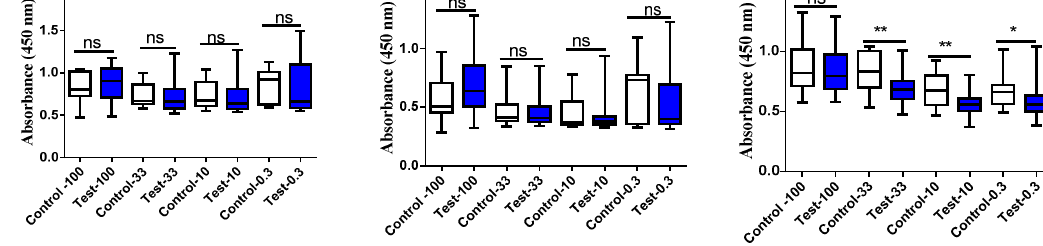
Figure 5. Fecal Ig responses against A. luteoalbus, C. globosum MTAV35 , and Trichoderma sp. (=atroviride 14/AM). Fecal IgG levels of both A. luteoalbus and C. globosum MTAV35 were increased in exposed sub- jects. With respect to Trichoderma sp. IgE values, the extensive variation complicates the interpretation but the variation in the results is not attributable to a single study subject. Boxplots indicate median values with 95% confidence intervals; statistically significant * p < 0.05, ** p < 0.01, *** p < 0.001 and **** p < 0.0001 when the study persons were compared to controls. Ns =